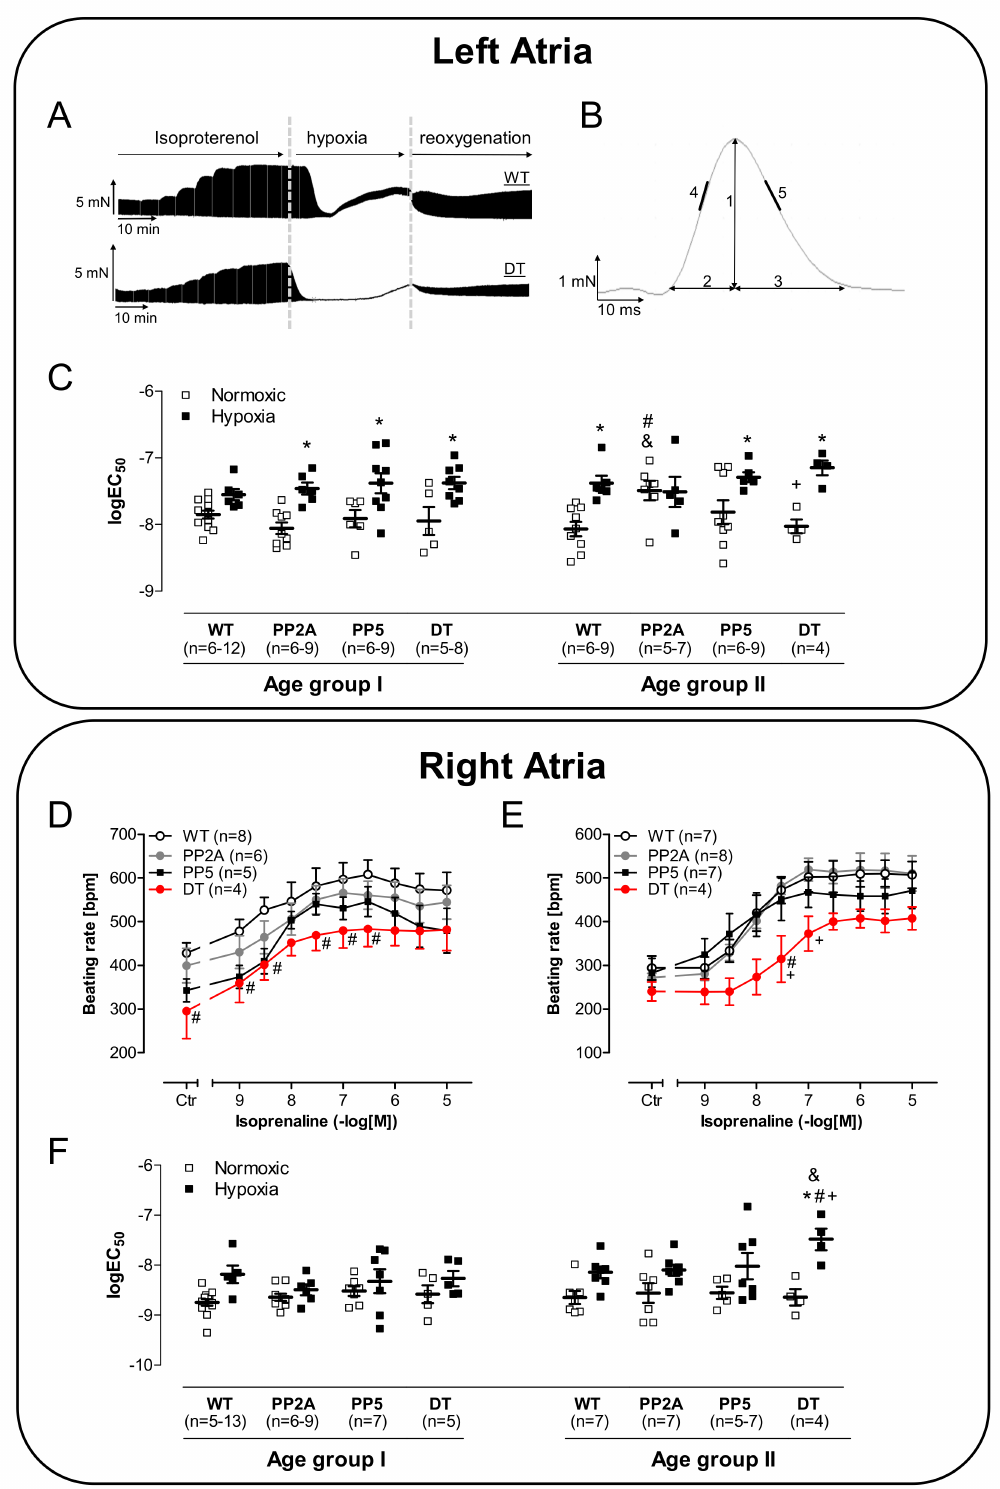
Figure 6. Typical original recordings of the contraction force in left atria ( A ) and the evaluated ranges of the peak ( B ) and corresponding logEC 50 -values on cumulative concentration response curves of isoproterenol of isolated left atrial preparations on contraction force of young (age group I) mice and middle-age (age group II) mice ( C ). # p < 0.05 vs. WT; + p < 0.05 vs. PP2A; § p < 0.05 vs. PP5; & p < 0.05 vs. age group I, n = 4–12. Cumulative concentration response curves of isoproterenol on beating rate in isolated spontaneously beating right atrial preparations under normoxic control conditions ( D ) or after hypoxia ( E ) in middle-age mice and corresponding logEC 50 -values ( F ). # p < 0.05 vs. WT; + p < 0.05 vs. PP2A; & p < 0.05 vs. age group I; * p < 0.05 vs. normoxic; n =